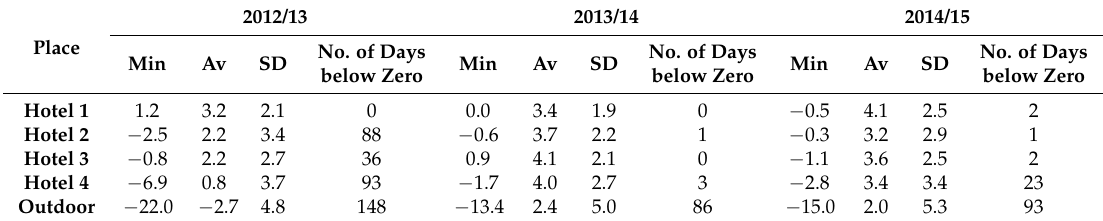
Table 1. Temperature (Minimum temperature ◦ C = Min, Average = Av, Standard deviation = SD) and